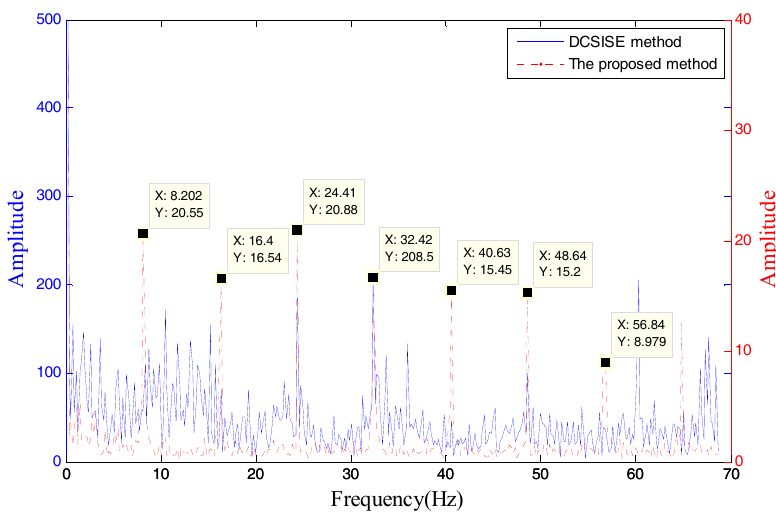
Figure 26. Comparison with the proposed method and DCSISE method.